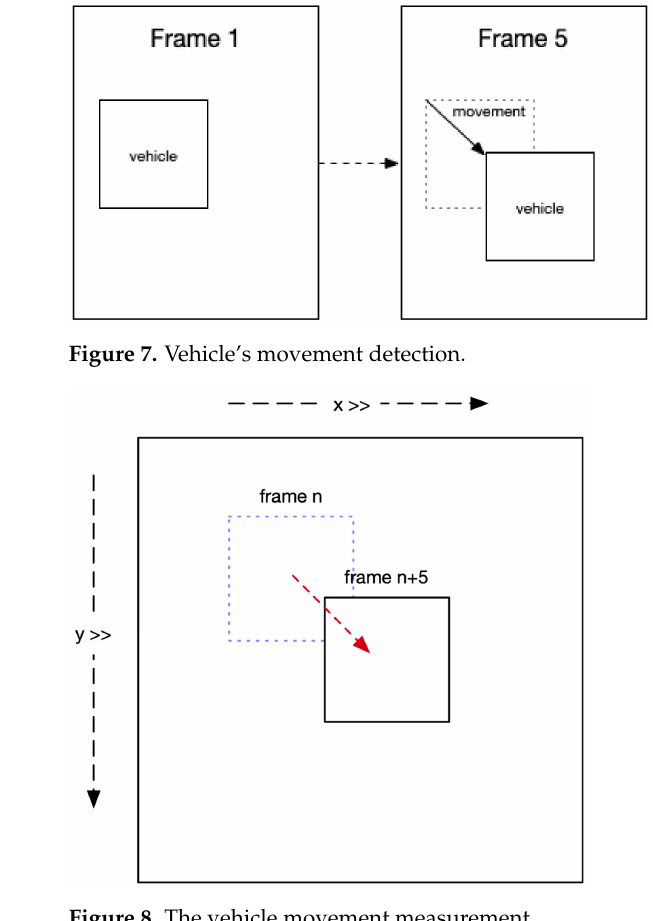
Figure 8. The vehicle movement